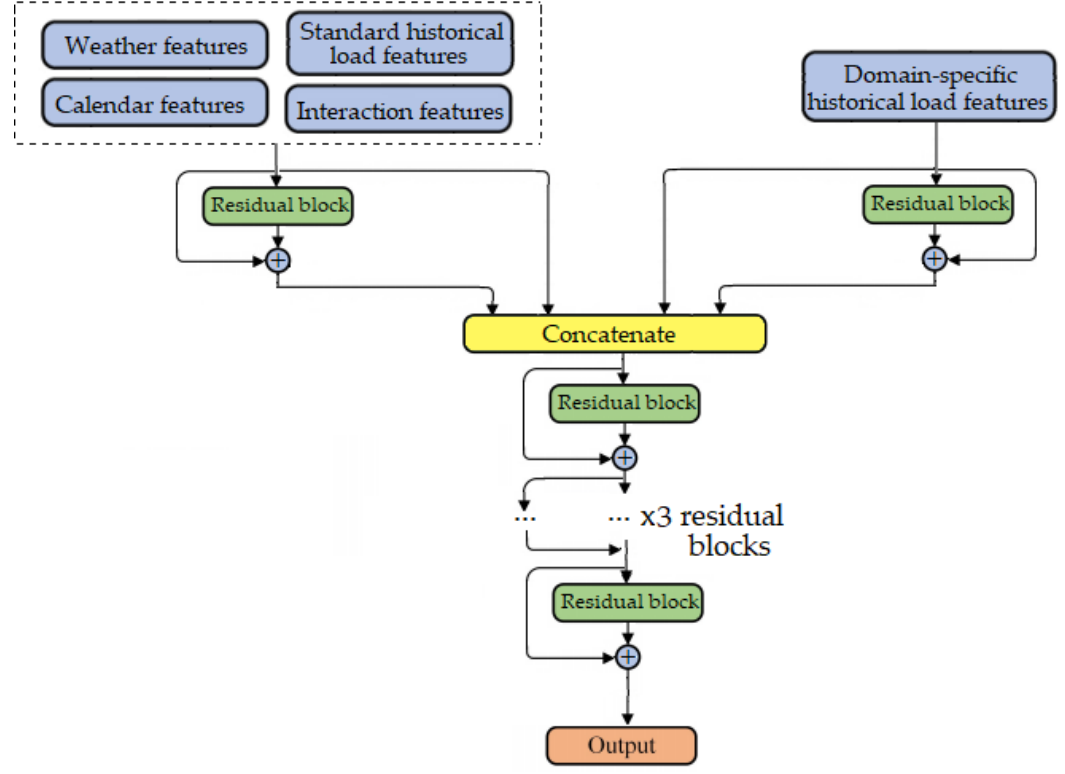
Figure 7. Proposed deep residual neural network (DRNN) architecture for short-term load forecasting (STLF).